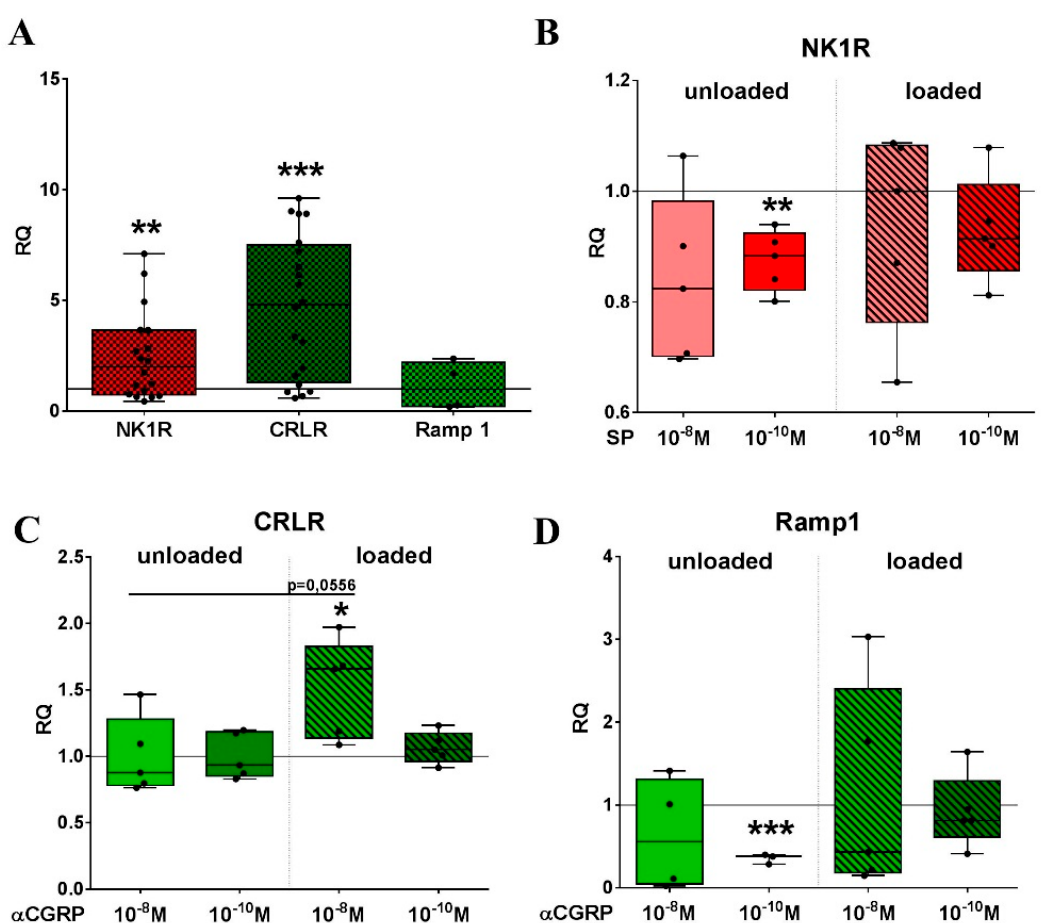
Figure 1. The impact of mechanical loading and neuropeptide stimulation on sensory neuropeptide receptor gene expression of RAW264.7 cells. ( A ) Relative gene expression of NK1R , CRLR and Ramp1 after 4 h loading per day on two consecutive days in relation to unloaded cells (= calibrator, RQ = 1) was analyzed using quantitative real-time PCR. Normalizer: GAPDH . One sample t -test ** p < 0.01; *** p < 0.001. NK1R, CRLR n = 20, Ramp1 n = 5; ( B – D ) Receptor gene expression was determined after 2 days of loading for 4 h per day in the presence of SP (B, for NK1R ) or α CGRP (C for CRLR , D for Ramp1 ) using quantitative real-time PCR. Normalizer: GAPDH . Gene expression of stimulated cells was calibrated to the expression of unstimulated cells (= calibrator, RQ = 1). One sample t -test * p < 0.05; ** p < 0.01; *** p < 0.001. n = 5. NK1R—neurokinin receptor 1, CRLR—calcitonin receptor-like receptor, Ramp1—receptor activity GAPDH—glyceraldehyde 3-phosphate dehydrogenase, α CGRP—alpha-calcitonin gene-related